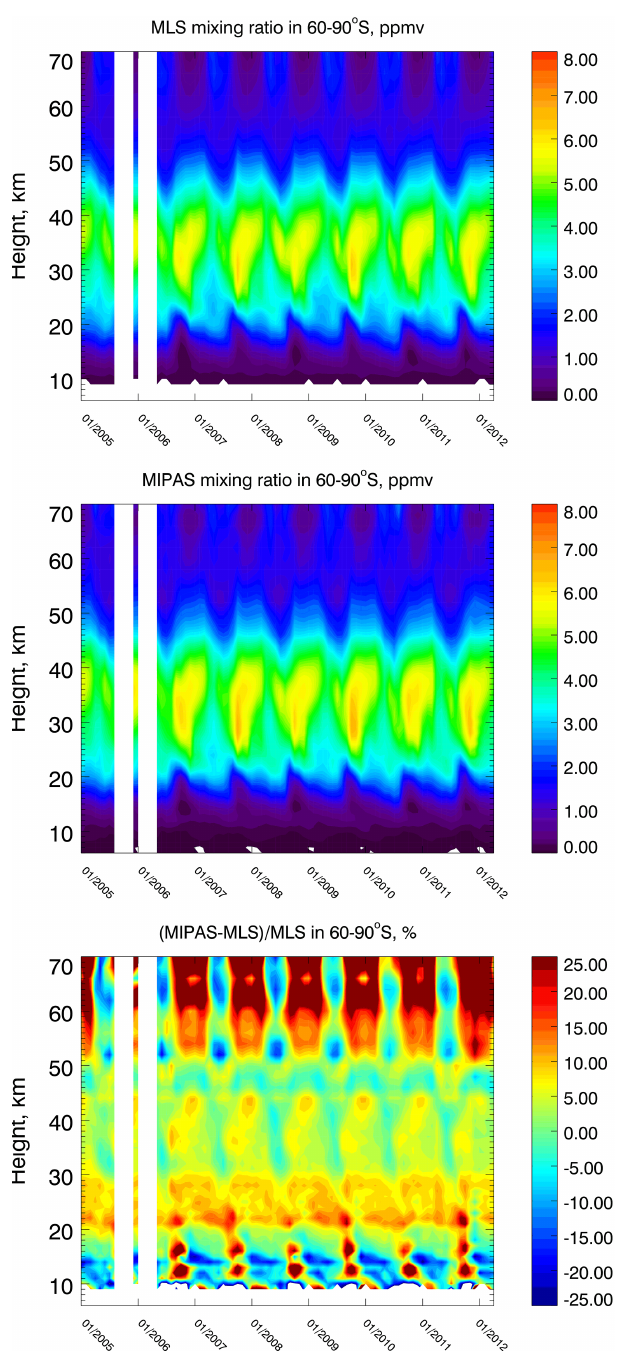
Figure 8. Monthly mean ozone values (in ppmv) of MLS (top panel), MIPAS (middle panel) and monthly means of relative MI- PAS–MLS differences (bottom panel) in 2005–2011 at 60–90 ◦